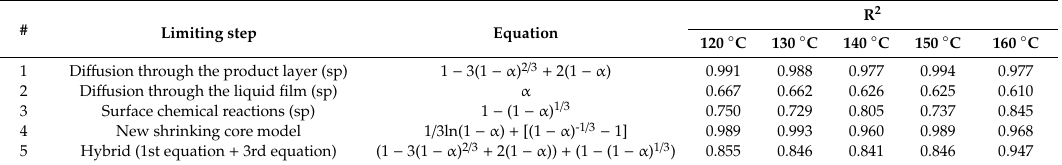
Figure 3. Dependence of 1–2/3 α − (1 − α ) 2/3 on time for Cu ( a ) and Ag ( b ) recovery into solution. Table 3. SCM equation fitting for Cu recovery from the initial low-grade concentrate.